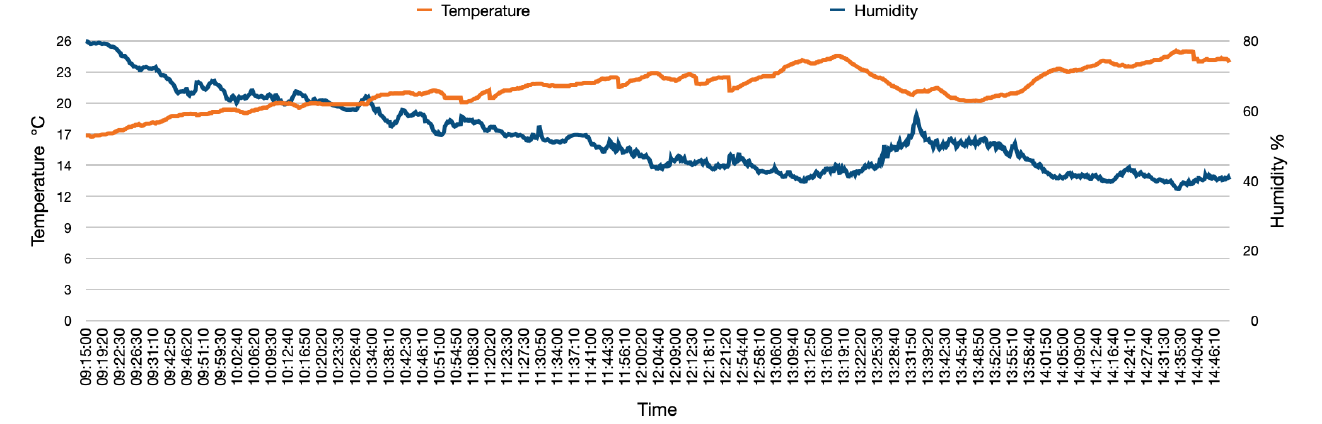
Figure 6. Ambient temperature and humidity during the field-trial.